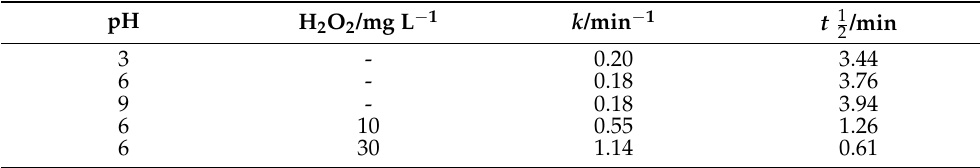
Table 1. Reaction rate constants and their half-lives of the degradation of metoprolol at pH 3, 6, and 9, and upon addition of H 2 O 2